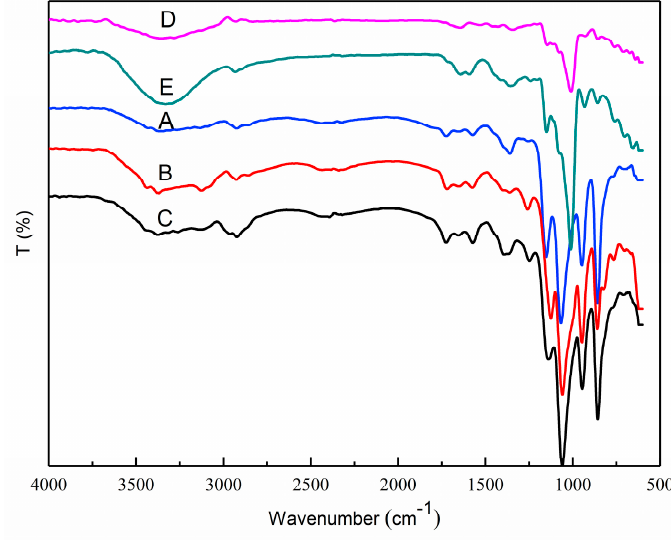
Figure 3. FTIR spectra: DS = 0.112 (A), DS = 0.286 (B), DS = 0.342 (C), native waxy maize starch (D) and SGC (E).